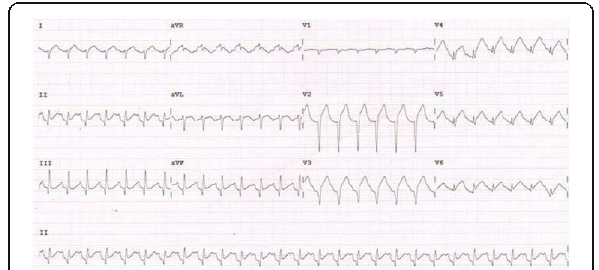
Fig. 4 Twelve lead ECG showing ST segment elevation in anterior leads and sinus tachycardia